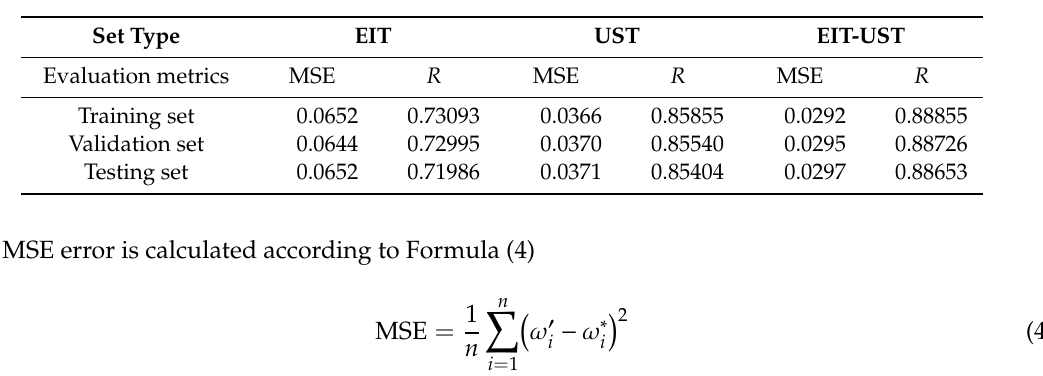
Table 3. Division of data sets into training, validation and testing.